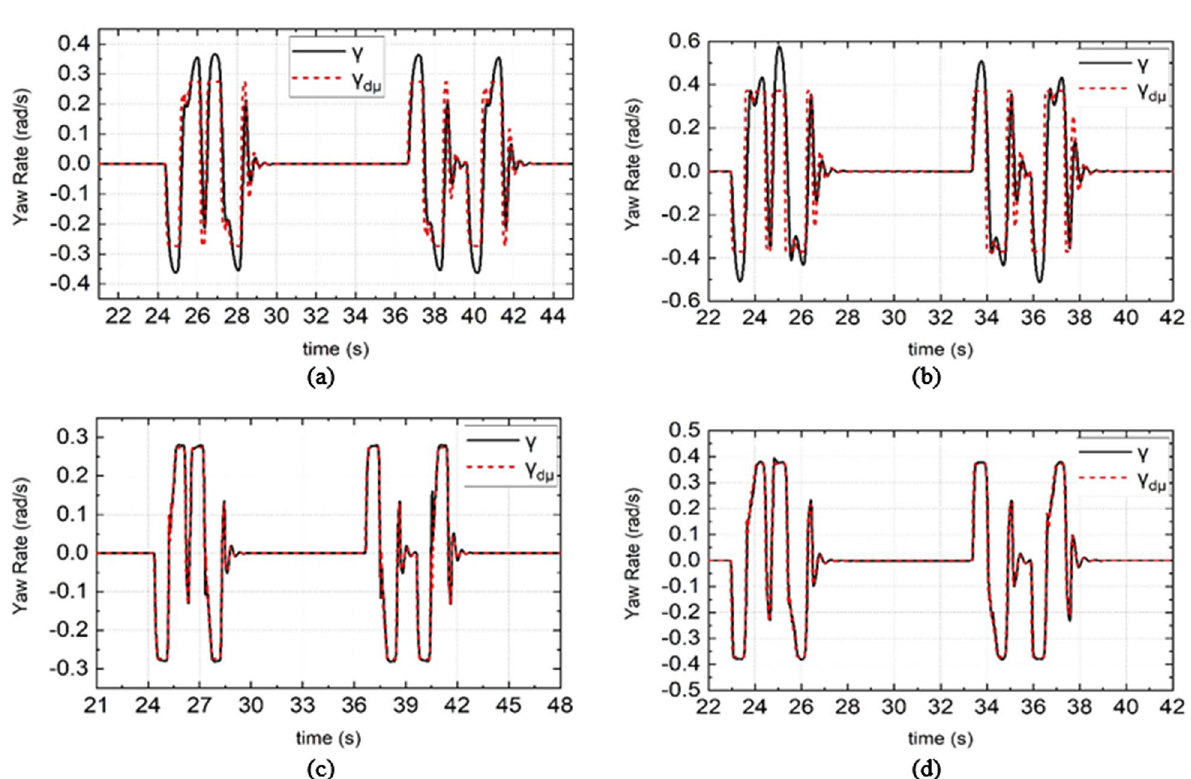
Figure 10. Simulation results of yaw rate under different road adhesion coefficient and different vehicle speed. ( a ) and ( c ) are the simulation results of DDAV running at 55 km/h on wet road, ( b ) and ( d ) are the simulation results of DDAV running at 65 km/h on dry